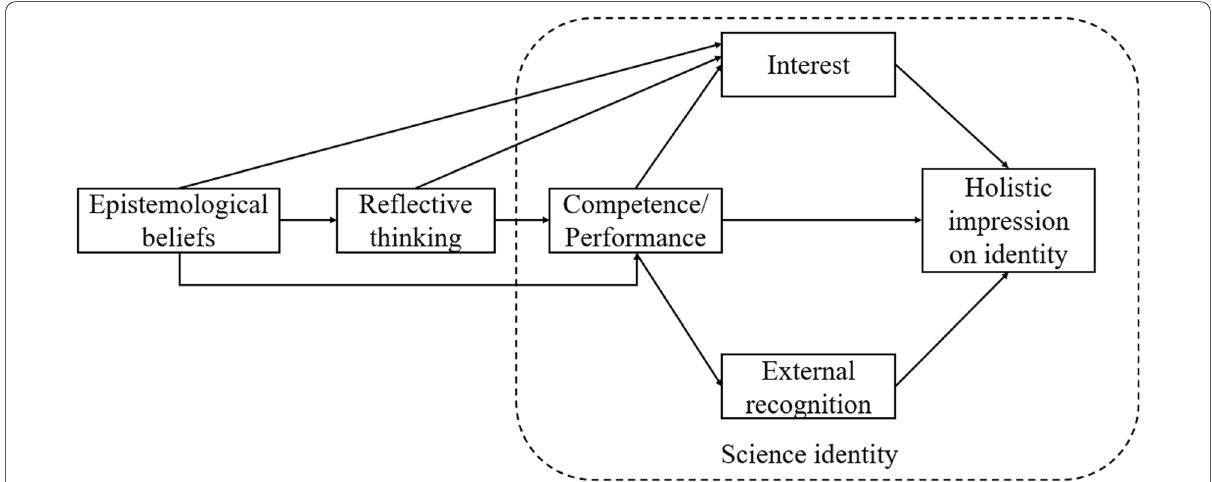
Fig. 3 The hypothesized model of the relationships between epistemological beliefs, reflective thinking, and science